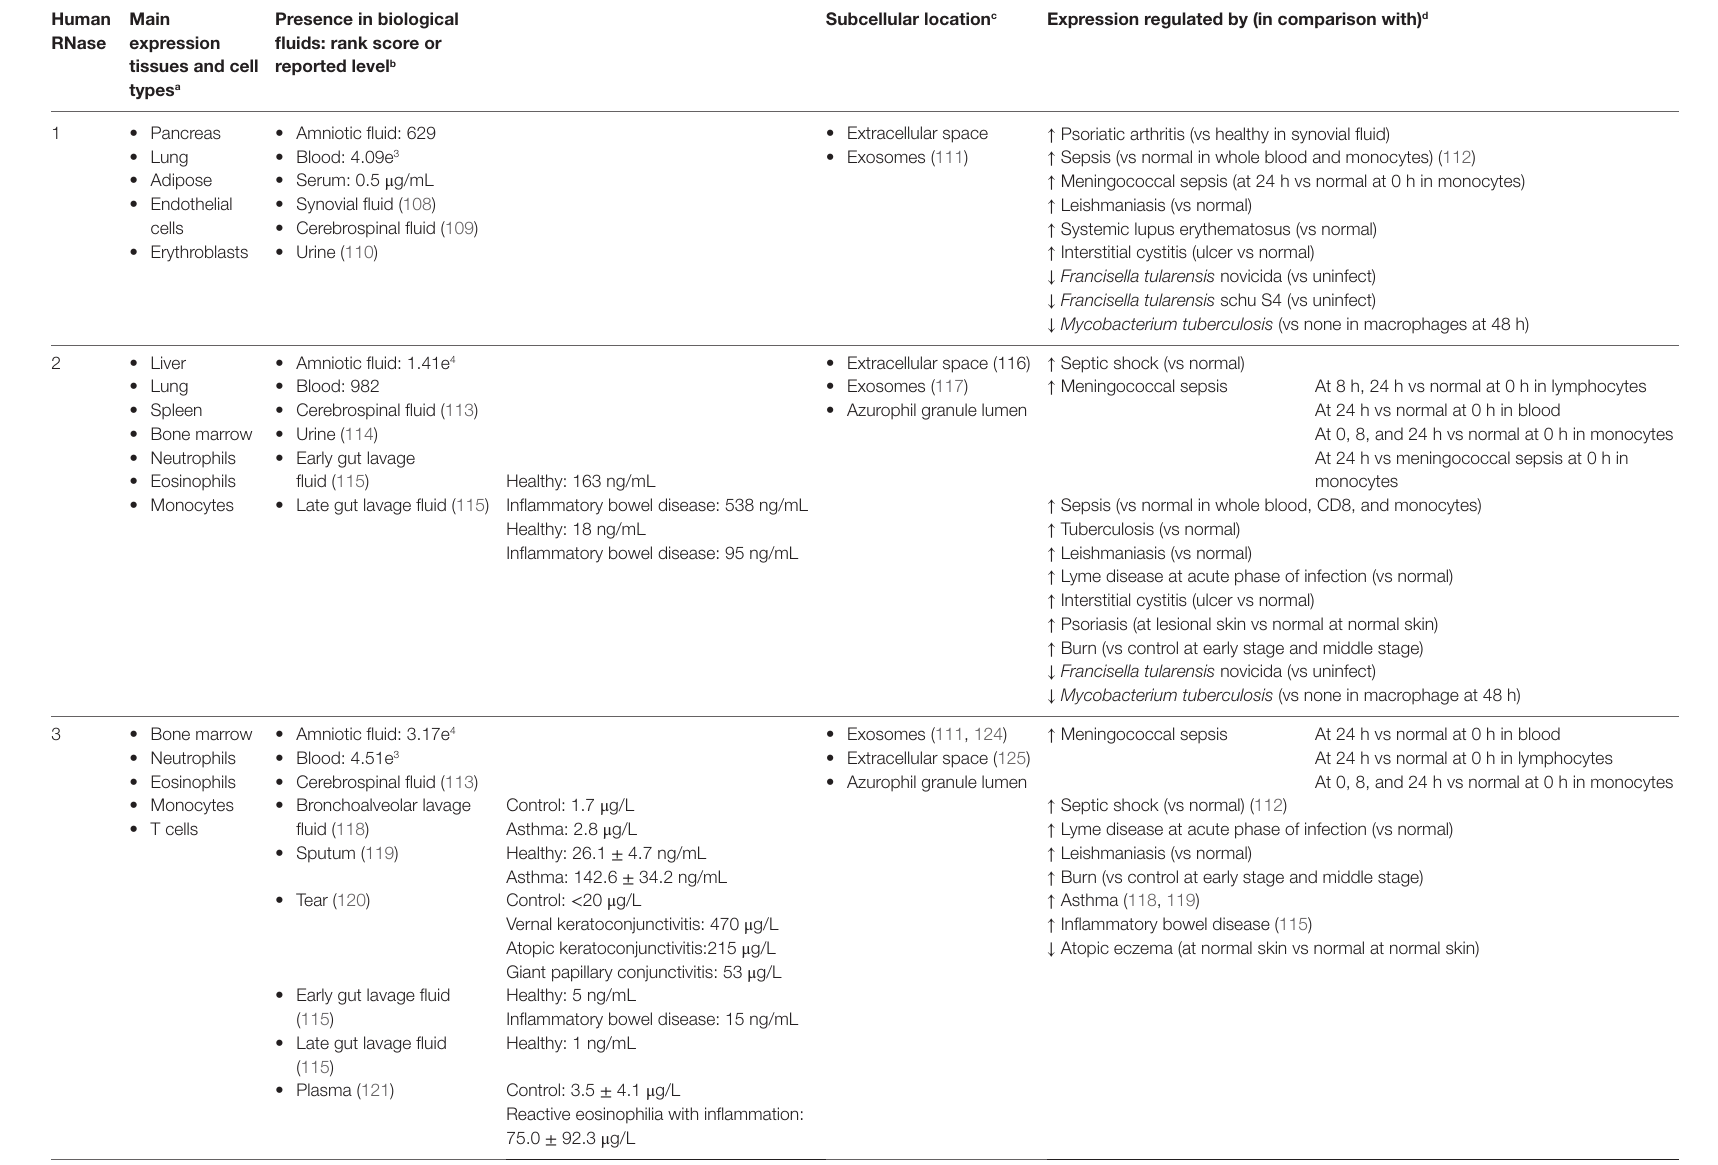
TABLe 2 | Expression profile and location of human secretory RNases. Human Main RNase